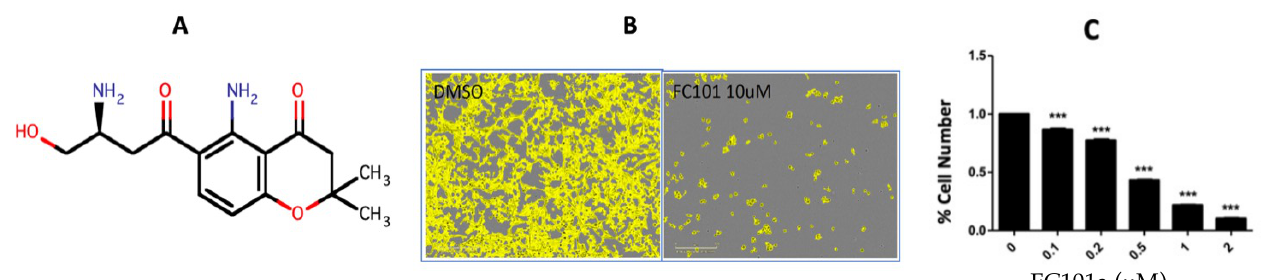
Figure 1. ( A ), the 2D chemical structure of fusarochromanone. ( B ), phase-contrast images of